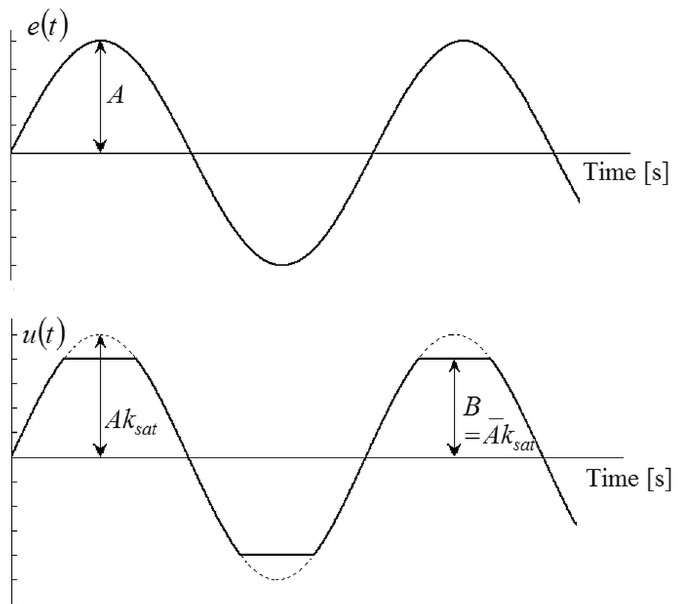
Figure 5. Sustained oscillations using the saturation